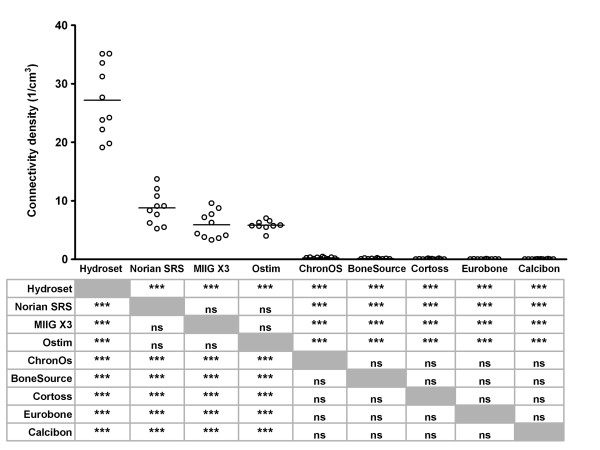
Connectivity density of bone substitutes The connectivity density of individual test samples was determined upon Micro-CT-scanning as described in the Materials and Methods. Each dot represents an individual test sample, and lines indicate the average value. The table below the figure shows the outcome of the pairwise comparisons (Student's T-test with Bonferroni correction). *, p < 0.05; **, p < 0.01; ***, p < 0.005; ns, not statistically significantly different. Grey boxes represent the self-self combinations, which could not be tested.